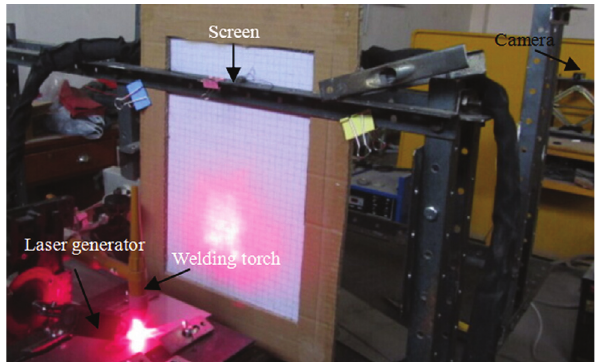
Figure 2: Experimental measurement